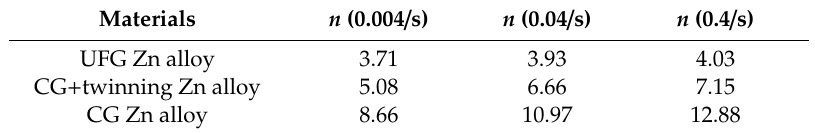
. ε − ln σ Figure 7. ln H H curves obtained at loading strain rate of 0.4 ln ln ε σ −  Figure 7. curves obtained at loading strain rate of 0.4/s ( a ), 0.04/s ( b ) and 0.004/s ( c ) holding time of 500 s in the UFG / CG + twinning / CG Zn alloy. H H with holding time of 500 s in the UFG/CG+twinning/CG Zn alloy. Table 1. Creep stress exponent ( n ) of UFG / CG + twinning / CG Zn alloy at